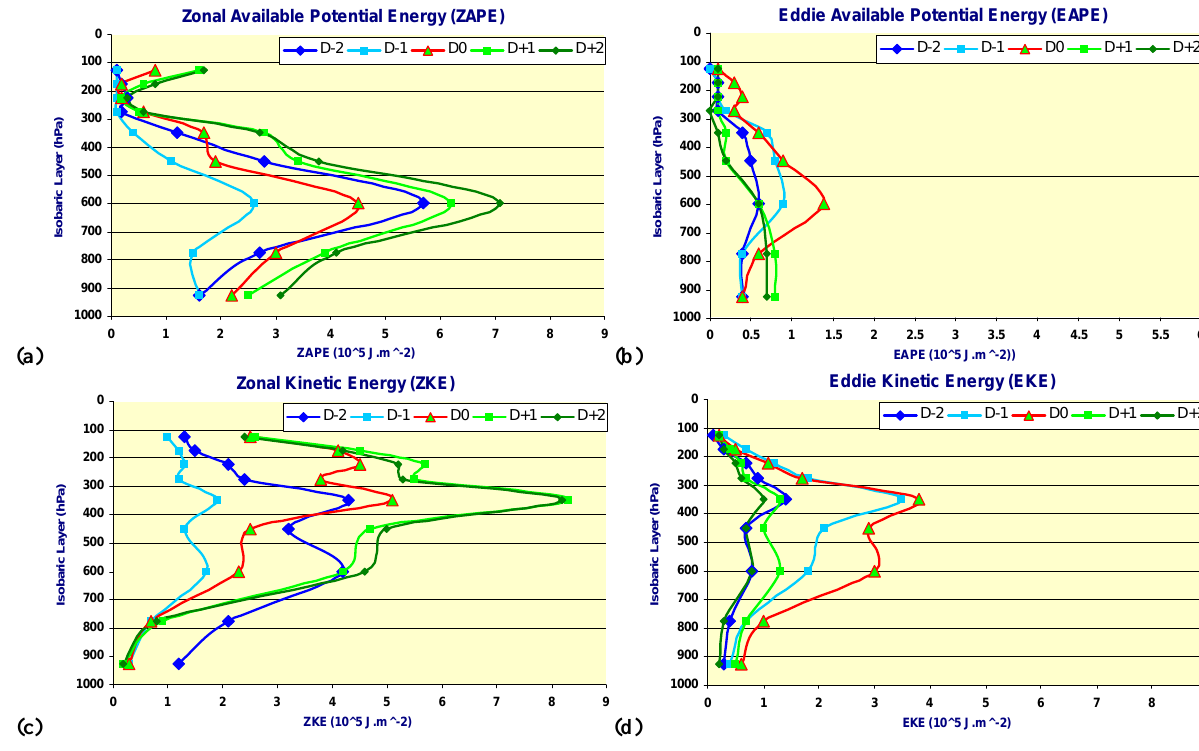
Fig. 13. Vertical distribution of (a) ZAPE, (b) EAPE, (c) ZKE, and (d) EKE on 27 (D-2), 28 (D-1), 29 (D0), 30 (D+1) and 31 January 2008 (D+2).